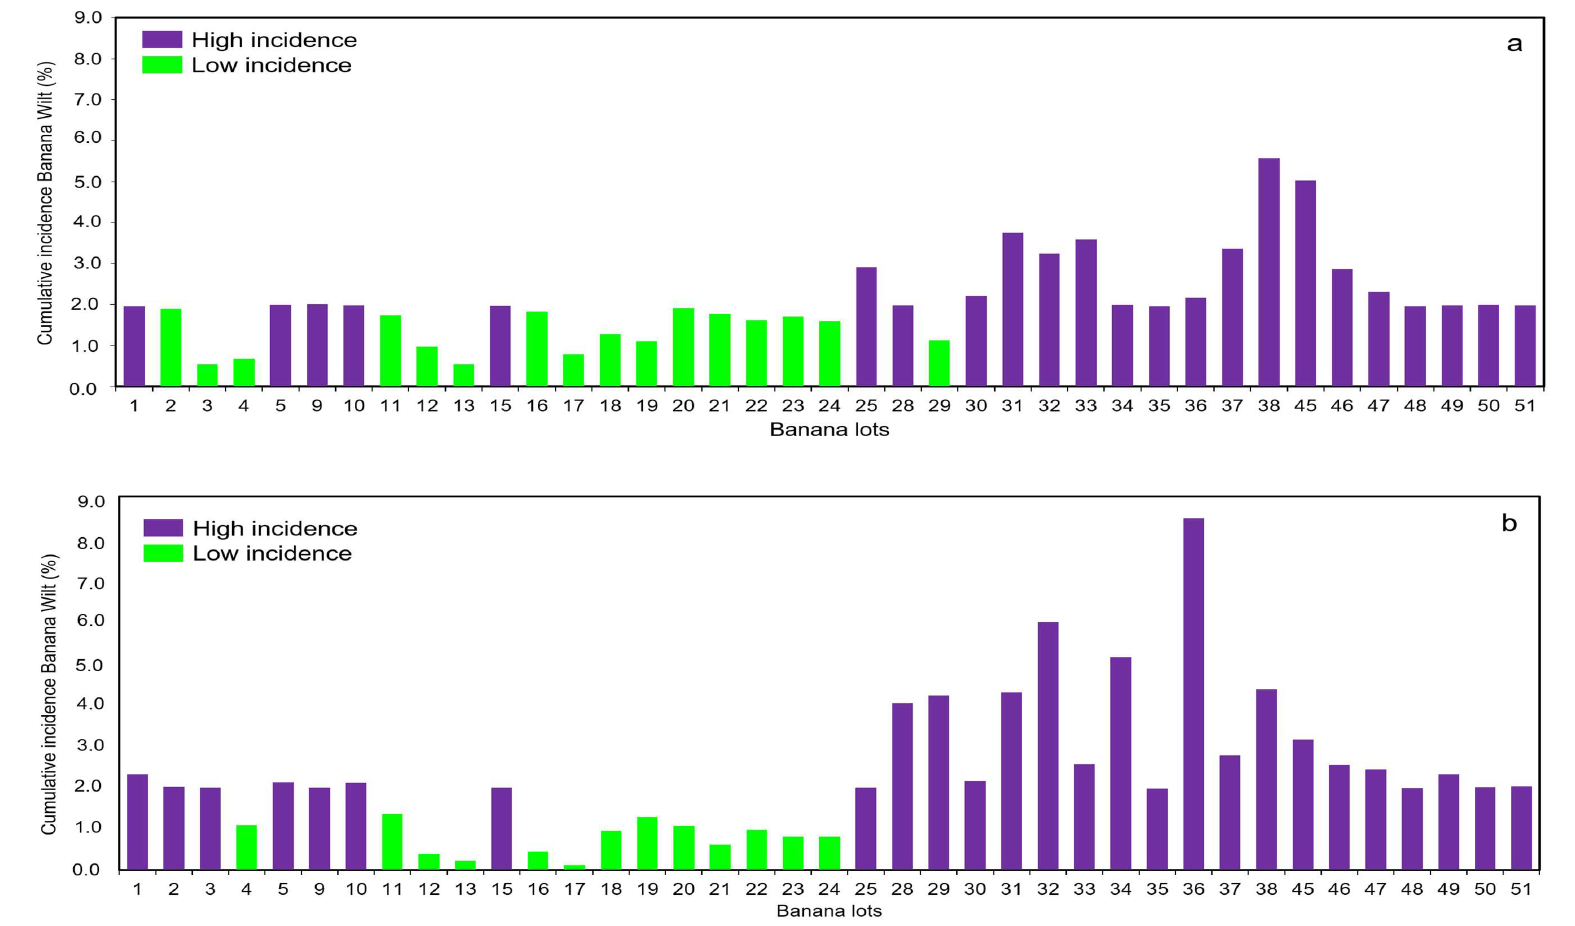
Figure 2. Cumulative incidence (%) of Banana Wilt in the study area during 2016 ( a ) and 2017 ( b ) ( n = 78; mean = 2.17 ± 1.40%; min = 0.11%; max = 8.47%; asymmetry = 1.78; kurtosis = 4.46; P 50 = 1.90%).